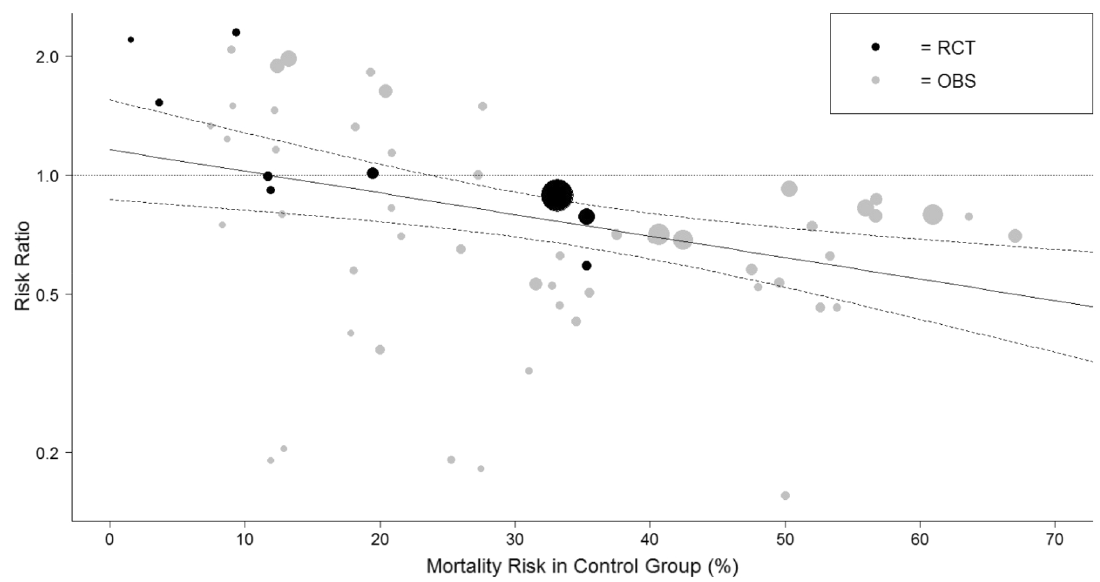
Figure 3. Graph showing the results from the meta-regression on baseline mortality risk, defined as mortality risk in the control group, and relative risk of mortality for patients treated with IL-6 (receptor) antagonists and patients not treated with IL-6 (receptor) antagonists. The size of the circles is inversely proportional to the variance of the estimated treatment effect. The Metafor R package was used to generate this figure 13,23 . The dashed lines represent the limits of the 95% confidence interval. RCT = randomized controlled trial (black dots). OBS = observational study (gray